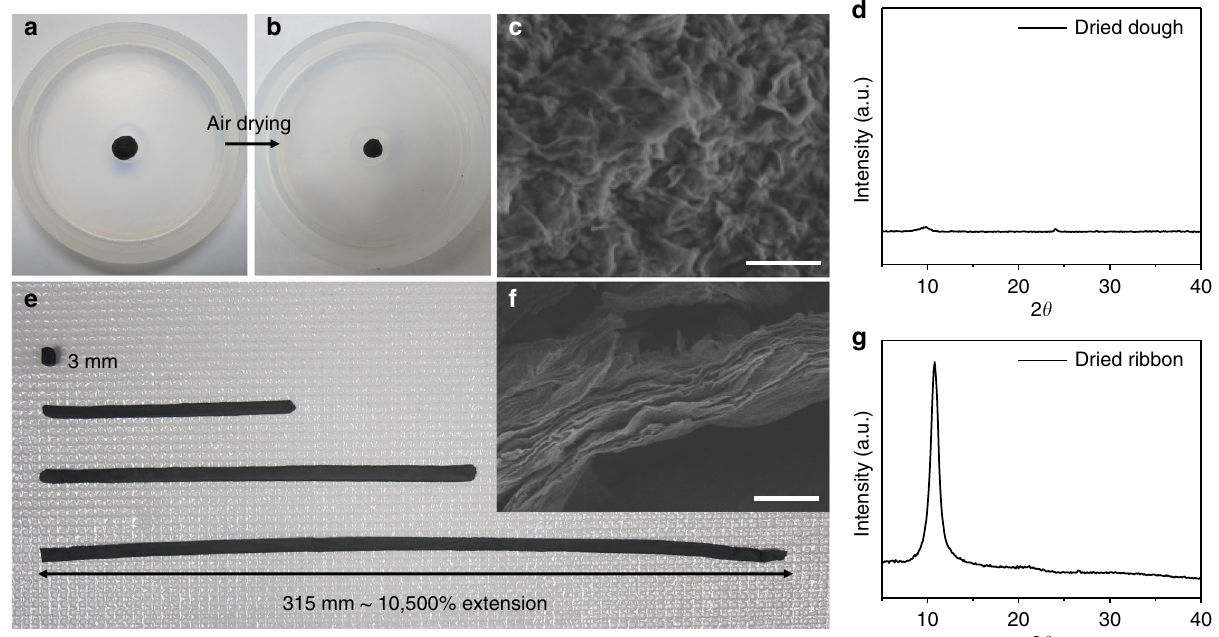
Fig. 4 Super extensibility of GO doughs. Photos of a ball-shaped GO dough a before and b after drying in air, showing slight volume shrinkage. c Cross- sectional SEM image of the dried solid does not show lamellar microstructure, which is consistent with d the lack of a strong diffraction peak in the XRD pattern of the air-dried GO solid. e A short block of GO dough can be repeatedly cold rolled to a long GO ribbon with 10,500 % of extension. f Cross- sectional SEM image of the dried ribbon shows the development of lamellar microstructure, which is consistent with g the strong diffraction peak ~ 11° in the XRD pattern. Scale bar in c is 10 μ m, and in f is 2 μ